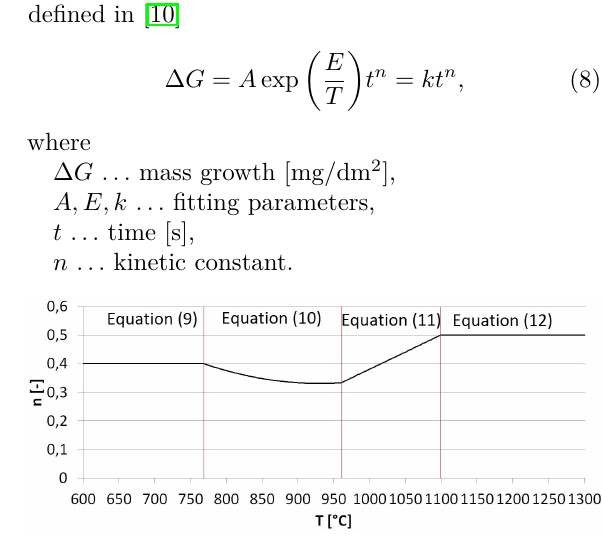
Figure 4. Development of the parameter n with temperature as defined by [10].